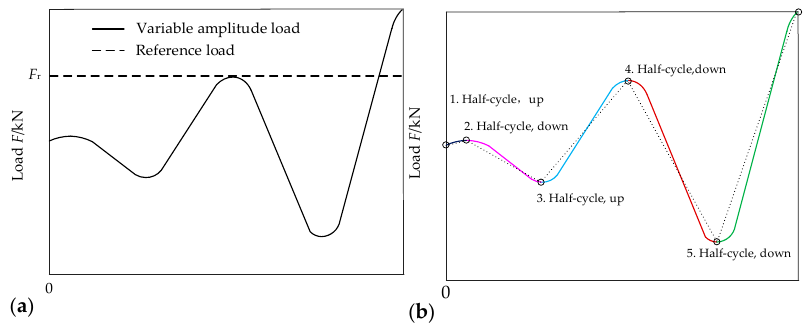
Figure 2. Rainflow-counting method: ( a ) loading history, ( b ) cycle count.